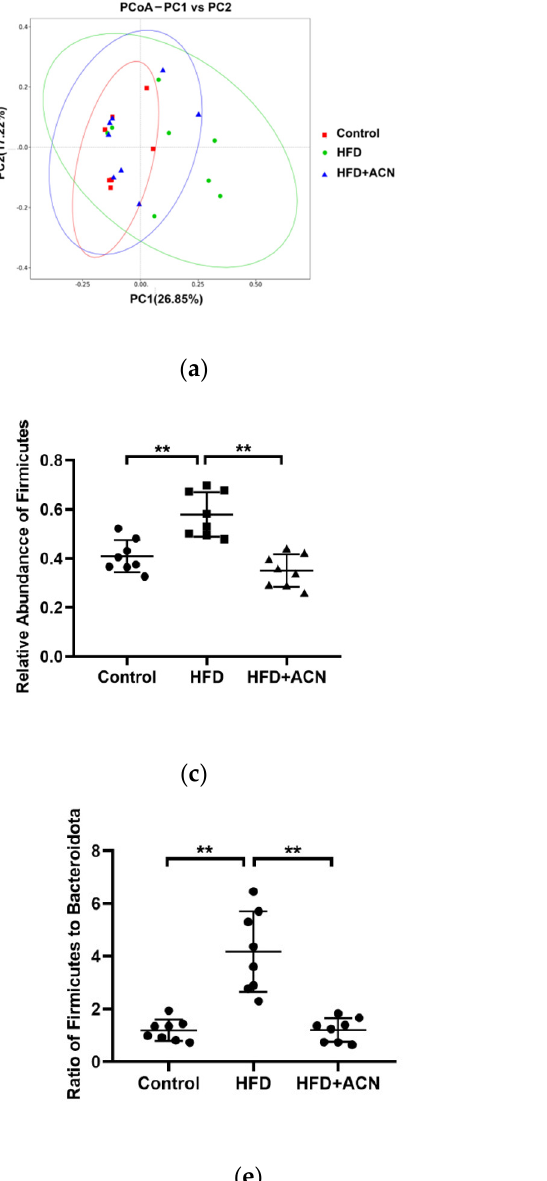
Figure 4. The changes in the gut microbiota structure at the phylum level. Data are expressed as the mean ± SD (n = 8 for each group), ** denotes p < 0.01. ( a ) PCoA plot. ( b ) Histogram of the relative abundance of the dominant bacterial phyla. ( c ) The relative abundance of Firmicutes . ( d ) The relative abundance of Bacteroidota . ( e ) The ratio of Firmicutes to Bacteroidota . ( f ) The relative abundance of Verrucomicrobiota .